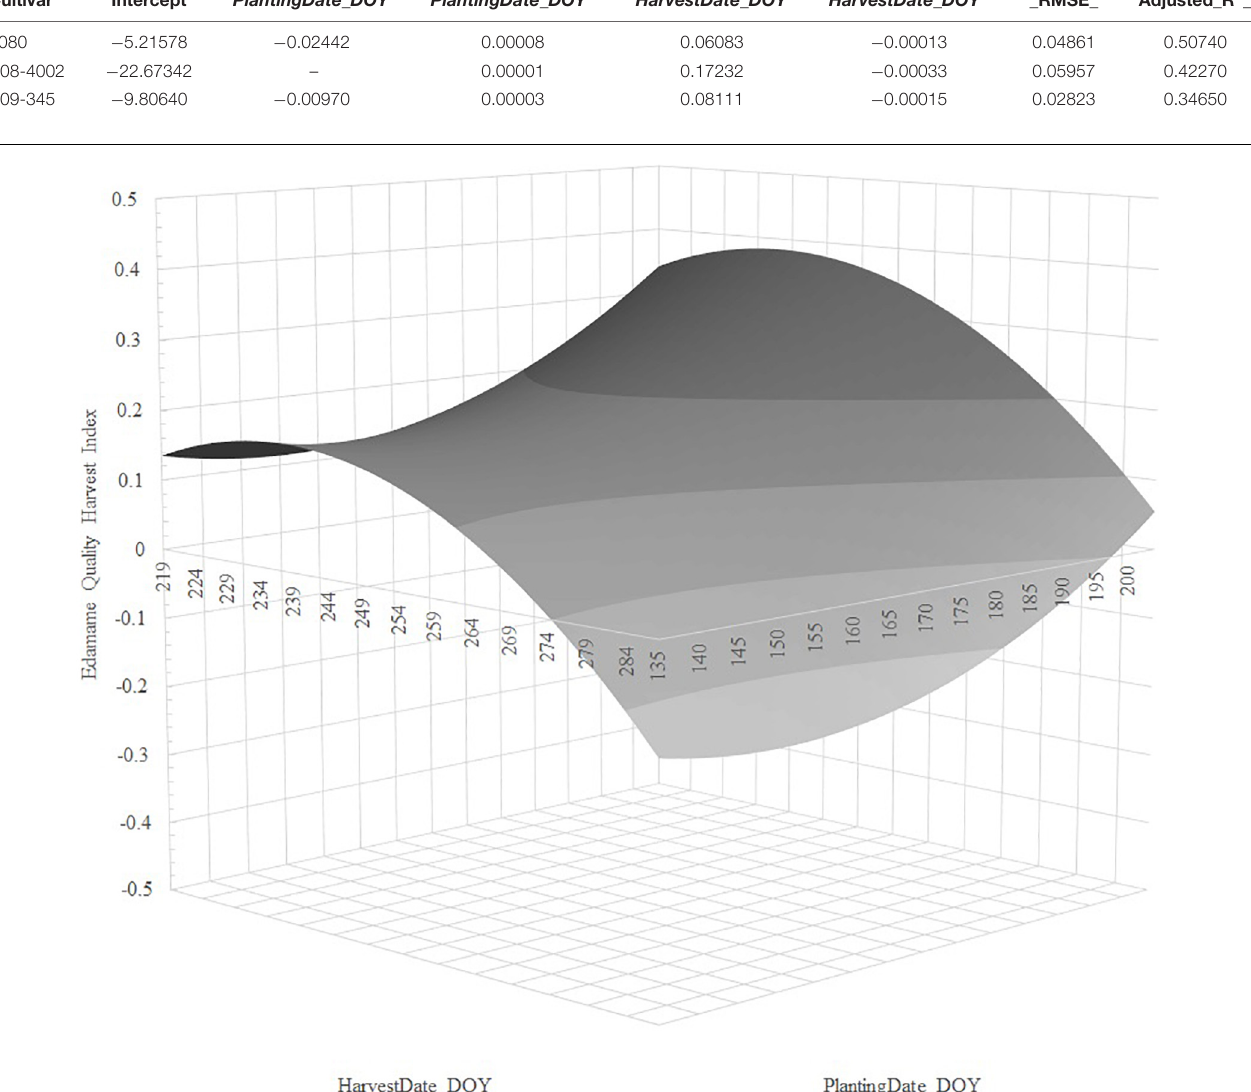
FIGURE 2 | Predicted response of Edamame Harvest Quality Index ( EHQI ) for cultivar 8080, as a function of the regression of EHQI on PlantingDate_DOY , PlantingDate_DOY 2 , HarvestDate_DOY , and HarvestDate_DOY 2 . Stepwise regression calculated from the dataset of edamame cultivar 8080 planted on two Arkansas locations over 2 years in three planting dates and subjected to up to eight harvests dates, approximately 5 days apart, between R5.8 and